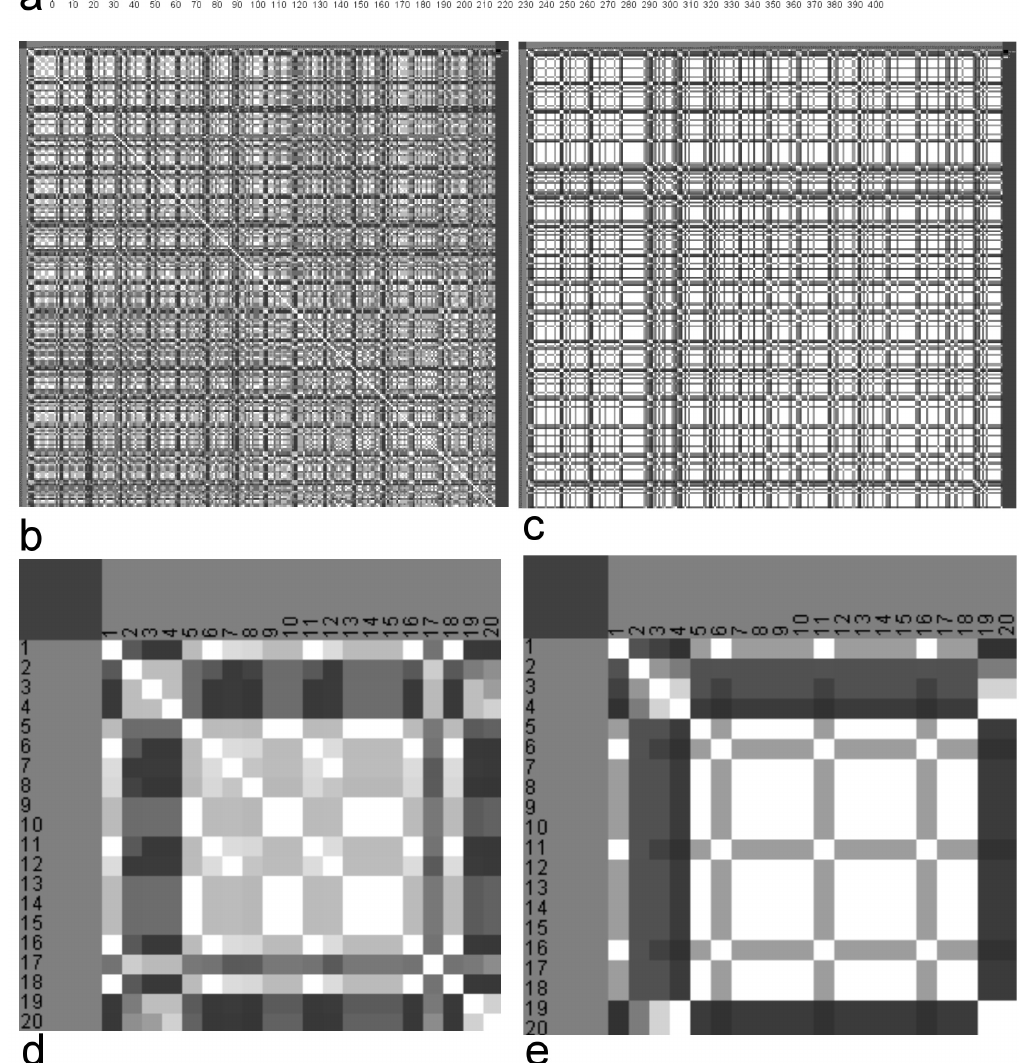
Fig 11. Similarities of clusterings referring GM parameter variation. The reaction parameters and decay rates for substances A and B were varied 256 times. a) RD functions of all regions using default parameters. b) Similarities of the clusterings using spectral clustering (Light: high similarity, dark low similarity). c) Similarities of the clusterings using Markov clustering (Light: high similarity, dark low similarity). d) Magnification of upper left corner of the matrix in b). e) Magnification of upper left corner of the matrix in